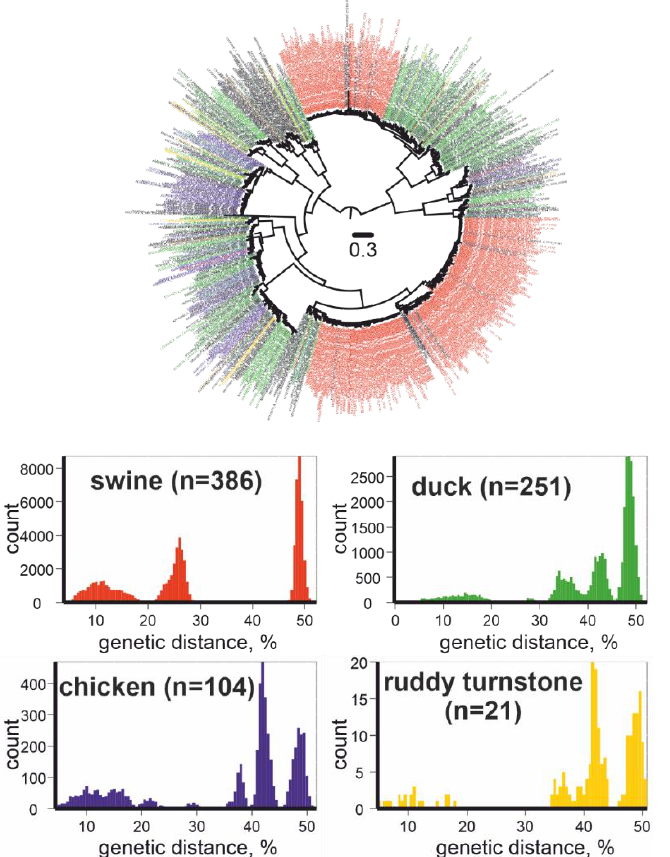
Figure 2. Upper panel: Unrooted maximum likelihood tree for IAVs (HA gene fragment, n = 1003). Red color indicates viruses collected from swine, green from ducks, blue from chickens, yellow from ruddy turnstones. Phylogenetic inference was performed using IQ-TREE [7]. Lower panel: pairwise genetic distances for IAVs collected from swine, ducks, chickens, and ruddy